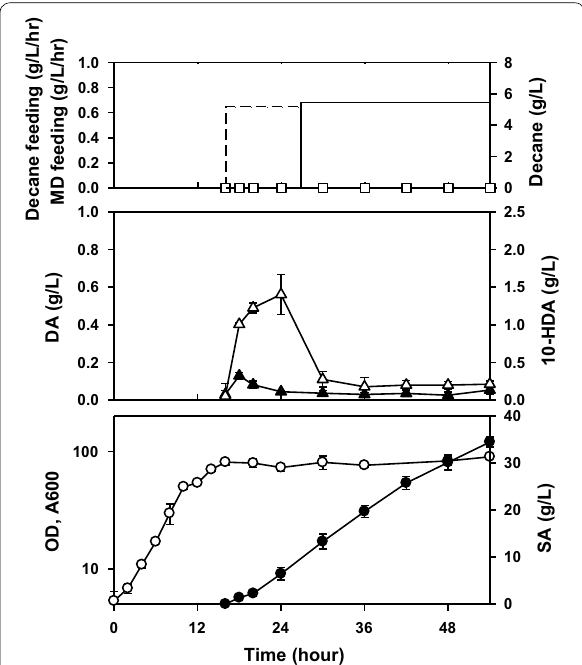
Fig. 5 Biotransformation of decane and methyl decanoate to sebacic acid using an evolved Candida tropicalis strain. In this experiment, decane was fed continuously during the induction period before the transformation of methyl decanoate. Error bars represent standard deviation of four measurements from two independent runs. Sym-